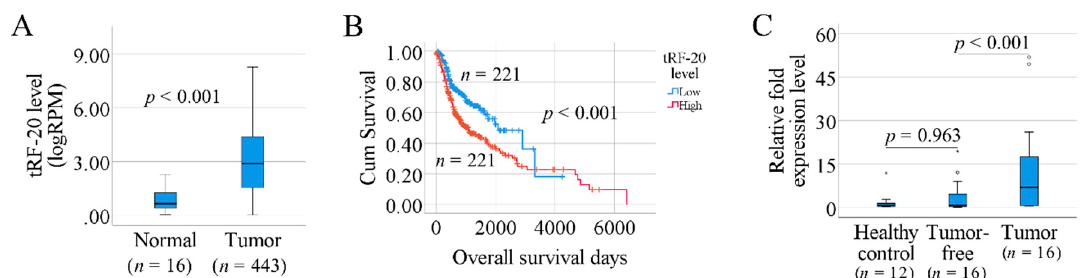
Figure 2. Investigation of tRF-20 in SCCHN. ( A ) Box-plots of tRF-20 levels in 16 normal and 443 tumor samples (TCGA data). ( B ) Kaplan–Meier curves showing the impact of tRF-20 levels on overall survival of patients with SCCHN (TCGA). ( C ) Box-plots showing relative fold expression levels of tRF-20 in 12 healthy controls and 16 pairs of tumor-free / tumor samples from patients with SCCOT (our clinical samples). Small circles indicate outliers and asterisks indicate extreme outliers.